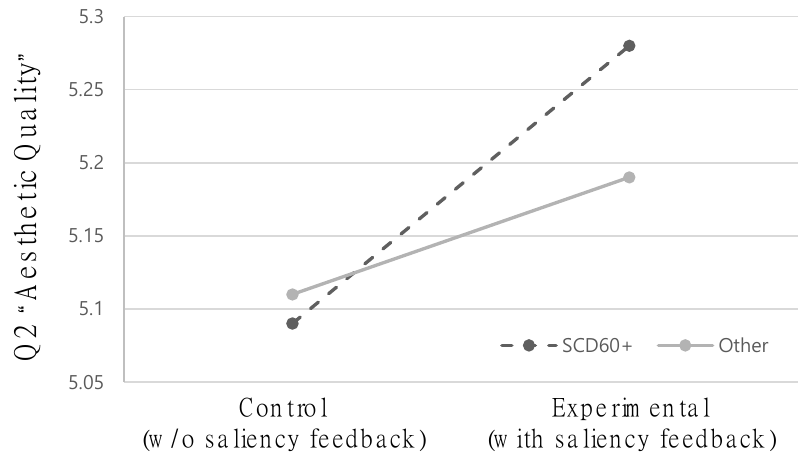
Figure 14. Interaction effect of the provision of saliency feedback during design and SCD on Q2. Older adults with SCD particularly appreciated the aesthetics of signs crafted with saliency, compared with other subjects’ appraisals. (Control: sign designs that were produced without prediction function, experimental: sign designs that were produced with saliency prediction function.)